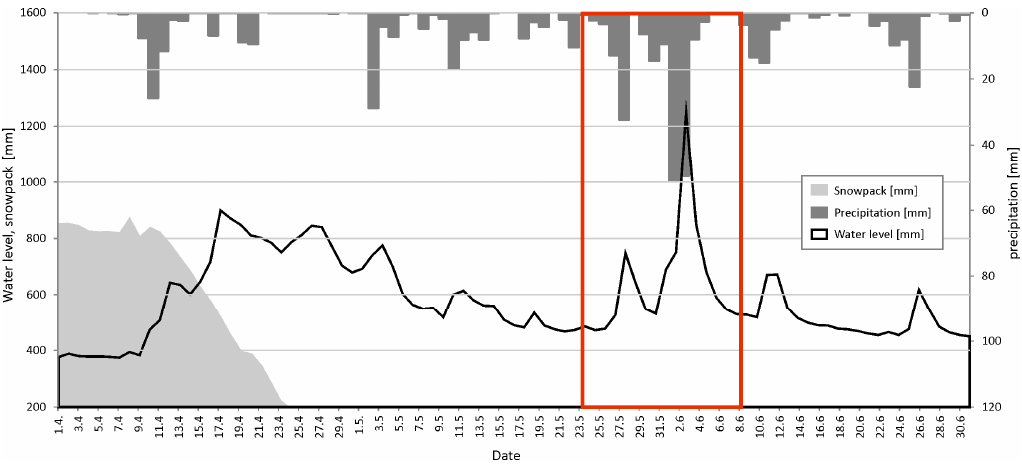
Figure 2. Flood event at Roklanský Brook in June 2013 as recorded by the Charles University in Prague (CUNI) sensor network with the marked period simulated by the model.